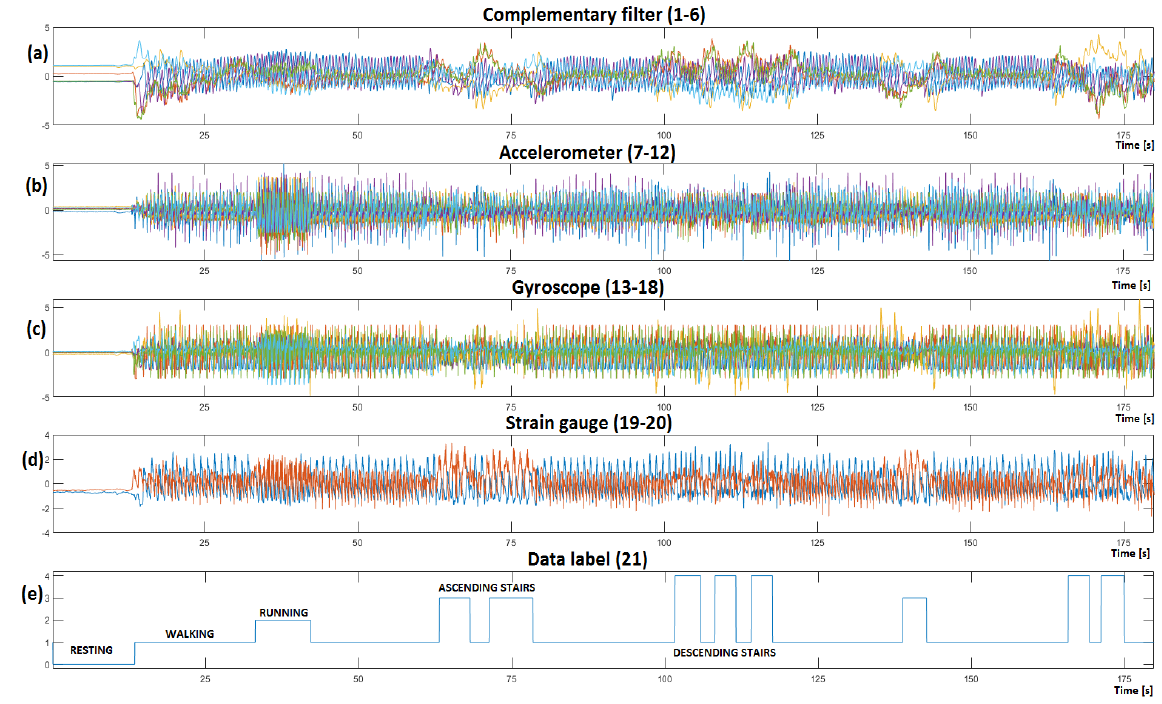
Figure 5. Recorded time–series gait data visualized (the displayed sensor information has already been normalized). Resting can be observed in 0–12 second’s intervals, walking from 12 to 33 s, running from 33 to 40 s, ascending stairs from 67 to 79 s and descending stairs from 105 to 118 s. ( a ) Visualizes the complementary filter’s gait information; ( b ) presents the accelerometer information; ( c ) Shows the gyroscope gait information, while ( d ) visualizes the left and right strain gauge sensor information; ( e ) shows the data label that was created with the data labeling Table 1. Features and their characteristics.